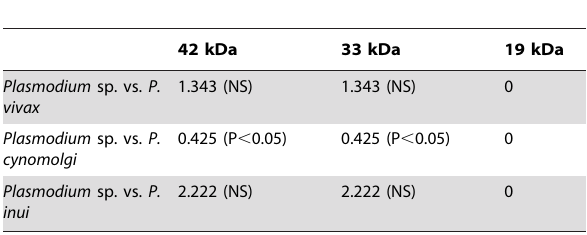
Table 3. McDonald and Kreitman test (neutrality index) for MSP1 42